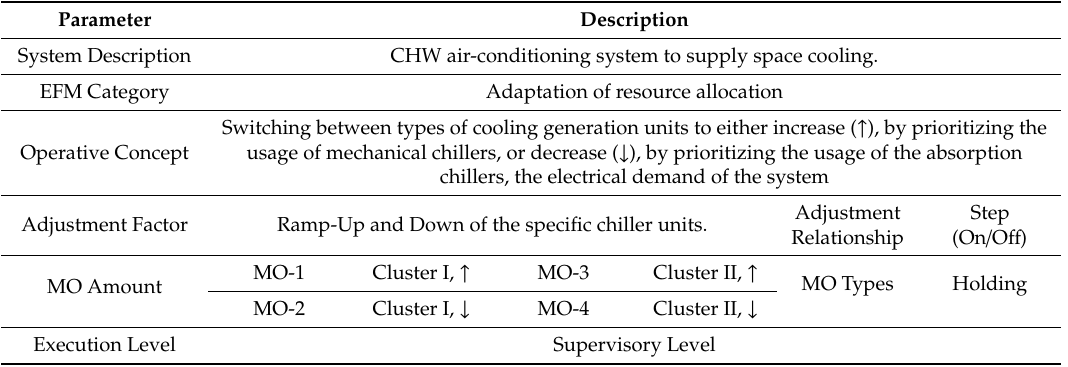
Table 7. Functional Dimension of the identified EFM 1